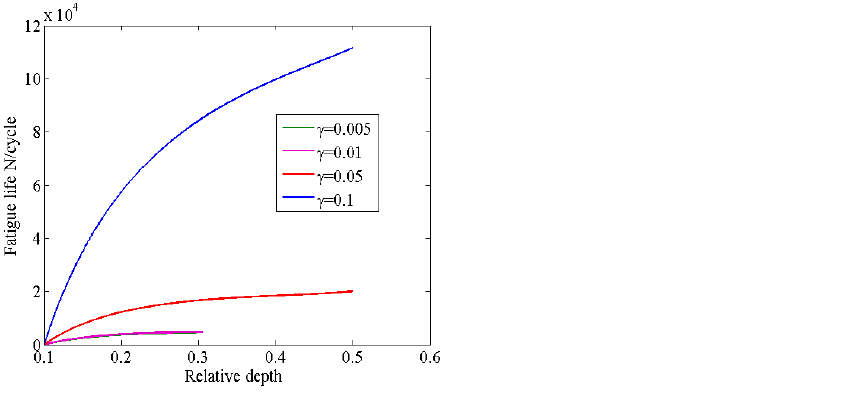
Figure 5. Vibration fatigue life curves as the damping loss factor changes.